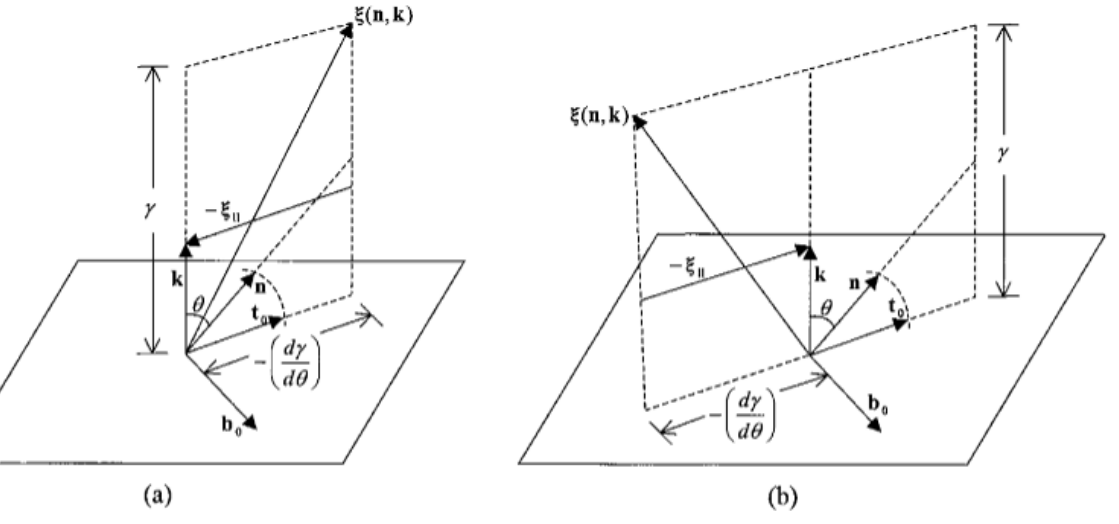
Figure 4. Schematic of the main vectors in the nematic Cahn-Hoffman vector thermodynamics for a ( a ) planar easy axis ( − d γ / d θ > 0) and ( b ) homeotropic easy axis ( − d γ / d θ < 0). The principal surface frame ( t 0 , b 0 ) is selected by the director orientation [80]. Reprinted (figure) with permission from Ae-Gyeong Cheong and Alejandro D. Rey, Physical Review E, 66, 021704 (2002). Copyright (2002) by the American Physical